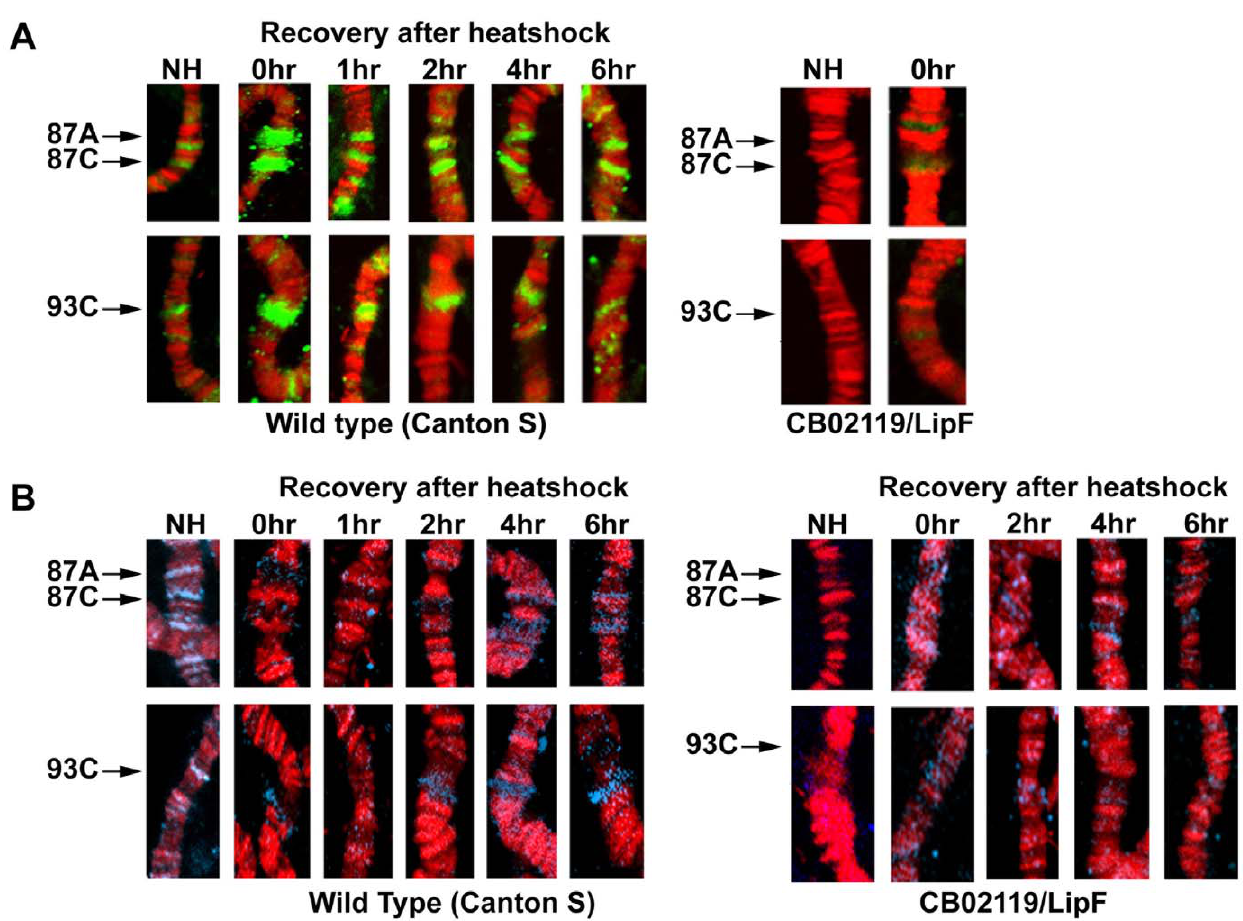
Figure 4. Recruitment of Rm62 and histone H3K9me2 proteins on polytene chromosomes and heat shock puffs. ( A ) The larvae were incubated at 37 u C for 45 min for immediate heat shock (0 hr recovery time) and subsequently transferred to normal culture temperature (25 u C). Larvae were dissected at different time points (1 to 6 hr recovery time). Non heat shocked (NH) larvae were used as controls. Immunostaining of a part of chromosome 3 covering 3 heat shock puffs (87A, 87C and 93C, using the nomenclature of [56]) with Rm62 Abs (1B8) ( A ) or H3K9me2 antibodies (blue) ( B ) from the wild type Canton S larvae before and after heat treatment (37 u C at 45 min) showing endogenous H3K9me2 bindings. The difference in accumulation of H3K9me2 at the heat shock puffs was visualized by the protein signals in blue (arrow